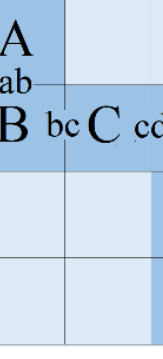
Figure 3. T-Groove( P1-P13 are the correlation surfaces of the features).